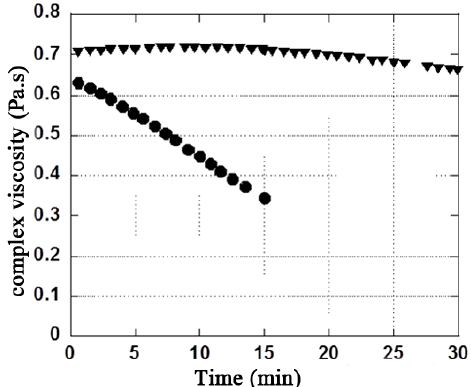
Figure 3. Kinetic of hyaluronic acid degradation (HA 10 g·L − 1 ) induced by hydrogen peroxide oxidative stress (0.3 mL of H without mannitol (35 g·L − 1 ) (  ). The variation of the complex viscosity |  *| is measured according to the time of degradation.